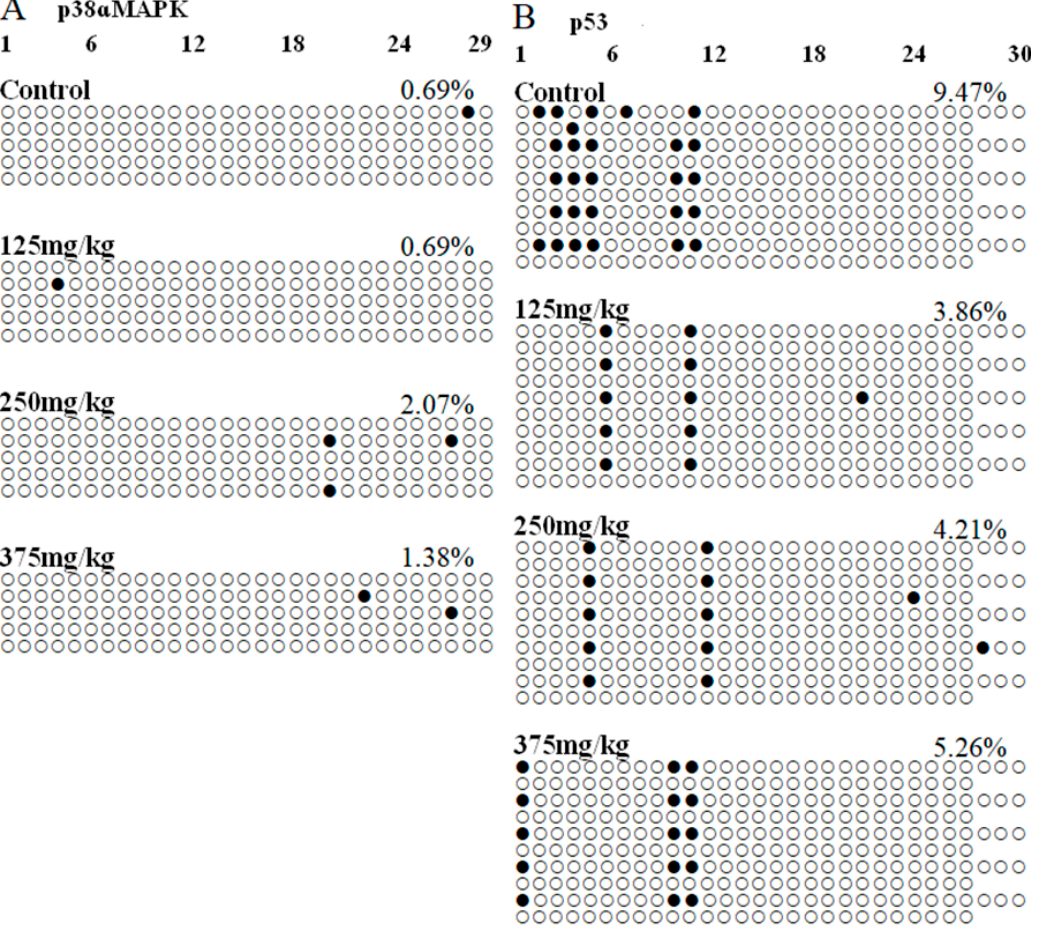
Figure 7. Effect of DEHP exposure on p38 ɑ MAPK and p53 gene promoter region methylation levels in the liver of mice ( n = 3).